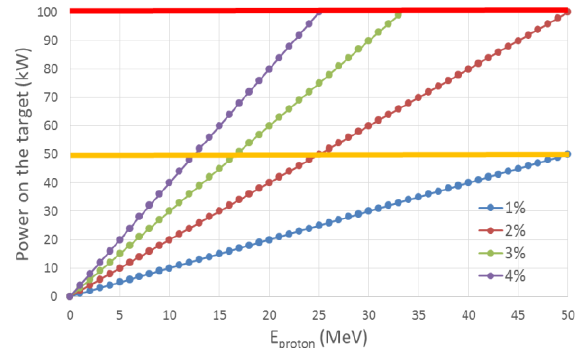
Fig. 2. Power on the target for increasing proton energies and various duty cycles from 1% to